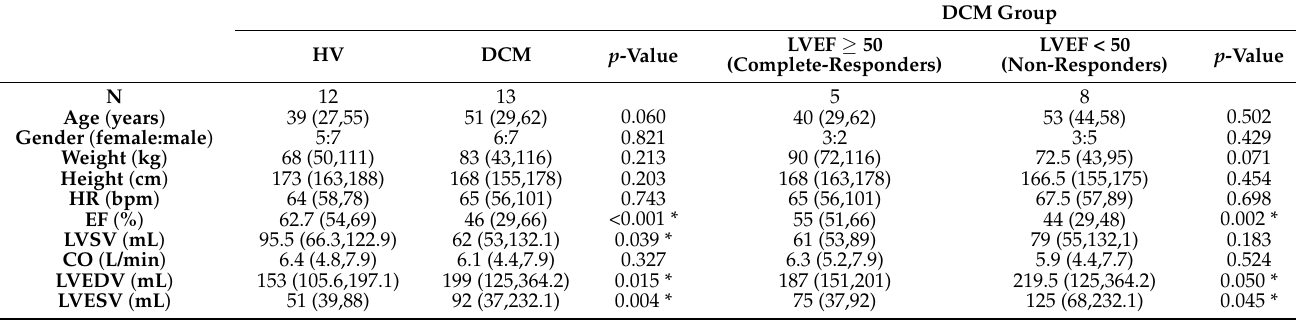
Table 1. Demographical and clinical data for healthy and DCM patients. All quantitative data are expressed as the median (range). HR: Heart Rate, EF: Ejection Fraction, LVSV: Left Ventricle Stroke Volume, CO: Cardiac Output, LVEDV: Left Ventricle End-Diastolic Volume, and Left Ventricle End-Systolic Volume. * indicates statistically significant differences ( p <